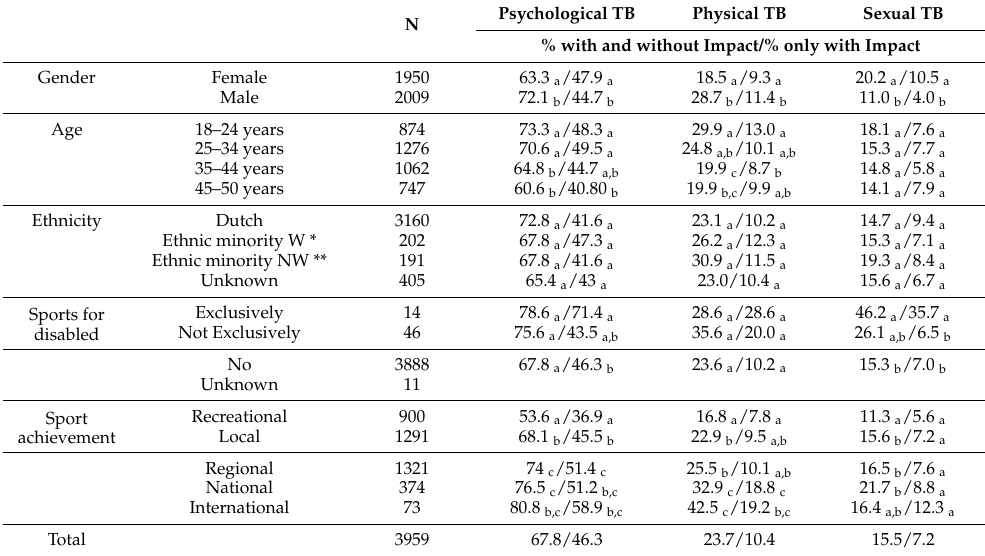
Table 4. Transgressive behavior classified according to gender, current age, ethnicity, participation in disabled sports, and highest sporting achievement.